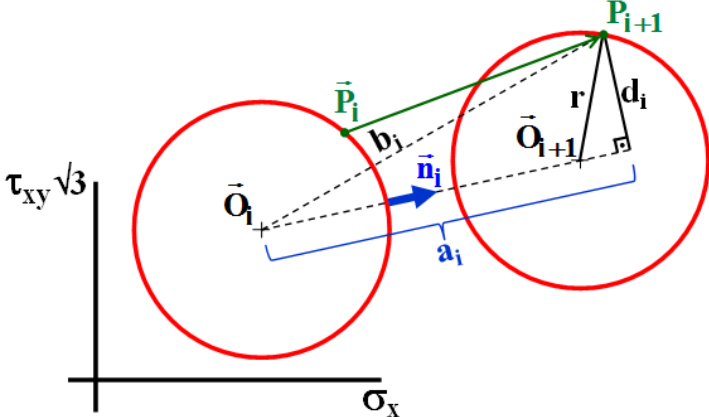
 n , caused by a peg movement from i